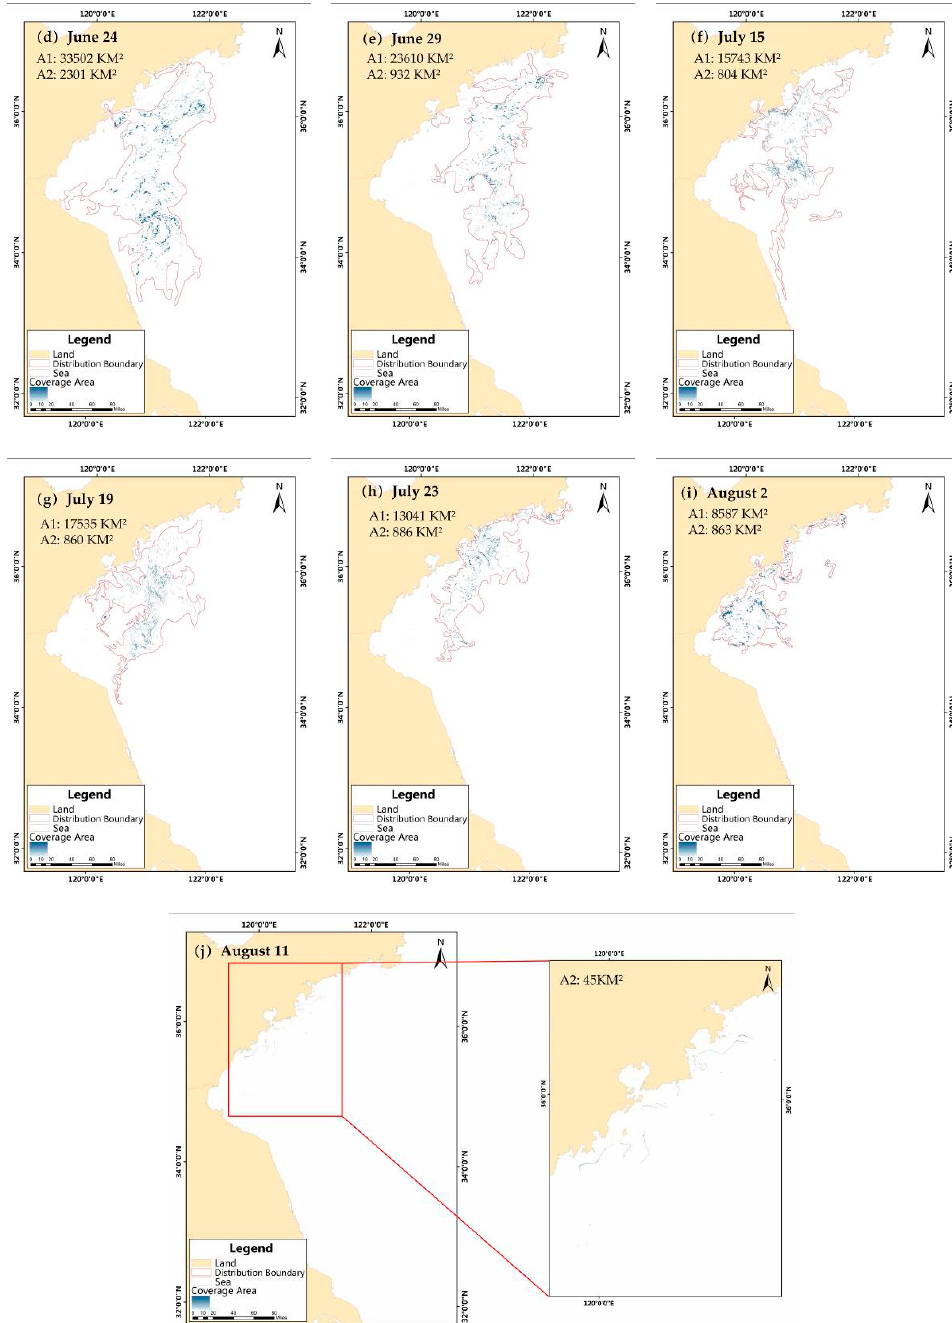
Figure 4. Spatial and temporal distribution of U. prolifera in the Yellow Sea, China in 2018. The area within the red line represents the distribution of U. prolifera . The blue gradient band represents the coverage area of U. prolifera , and the darker the color, the denser the algae are. The statistical values of the two kinds of areas appear in the upper left corner of each sub-figure; A1 denotes the affected area, and A2 represents the coverage area. ( a ) The situation of U. prolifera on June 3. ( b ) The situation of U. prolifera on June 12. ( c ) The situation of U. prolifera on June 21. ( d ) The situation of U. prolifera on June 24. ( e ) The situation of U. prolifera on June 29. ( f ) The situation of U. prolifera on July 15. ( g ) The situation of U. prolifera on July 19. ( h ) The situation of U. prolifera on July 23. ( i ) The situation of U. prolifera on August 2. ( j ) The situation of U. prolifera on August 11. In image ( j ), U. prolifera exists as only a slender filament, which has a negligible effect on the larger area. Therefore, only its coverage is counted. (Coordinate system: